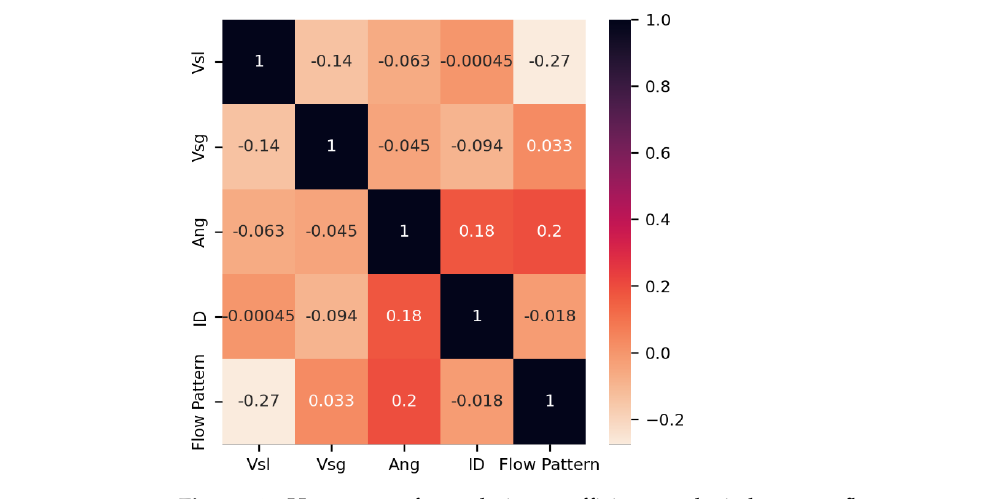
Figure 5. Pair-plot for exploratory data analysis of top four feature variables (V sl , V sg , Ang, and ID).